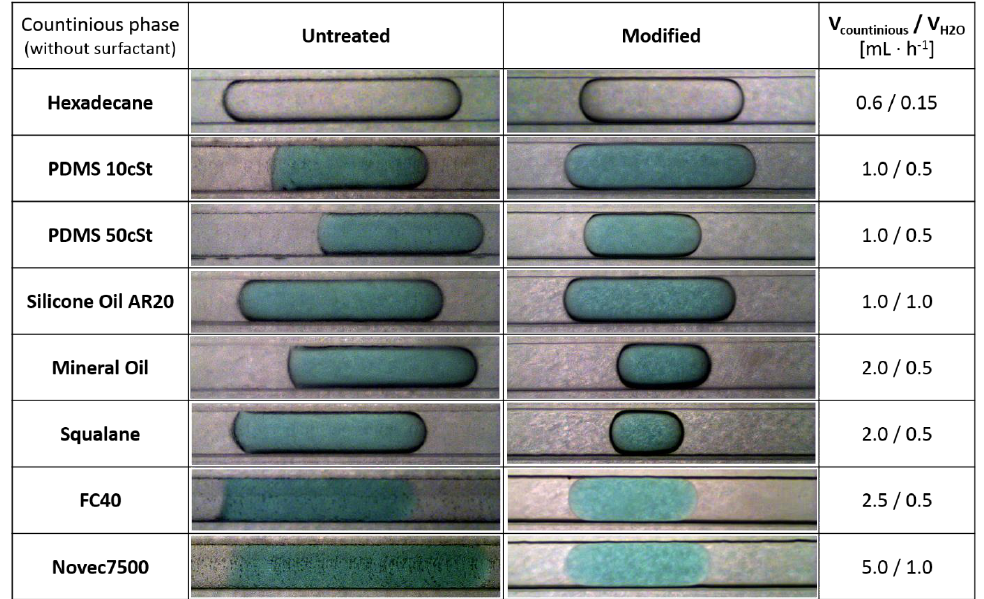
Figure 6. Contact angle (CA) of water drops deposited on the untreated and NH 3(aq) modified PC slabs (details in Figure) in surrounding various oils. CA was measured through the water degrees at the oil/water/solid interface. The volume of water droplets was 2 µL.